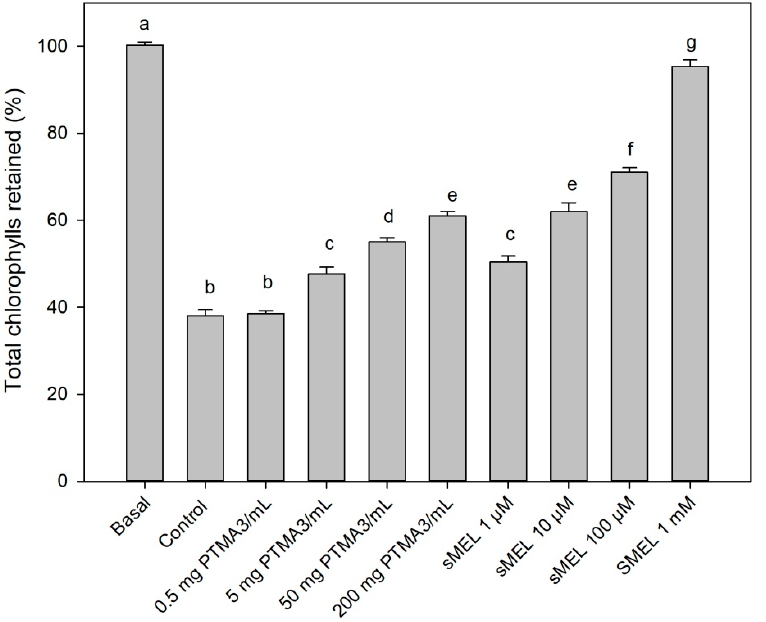
Figure 4. Effect of PTMA3 and synthetic melatonin (sMEL) on the total chlorophyll retained in parsley leaves incubated in a buffered medium and a control medium (only buffer) in darkness. Basal (day 0) corresponds to fresh leaves not treated. Error bars represent standard errors of the mean of four replicate experiments (n = 4). Different superscript letters indicate statistically significant differences at p < 0.05.